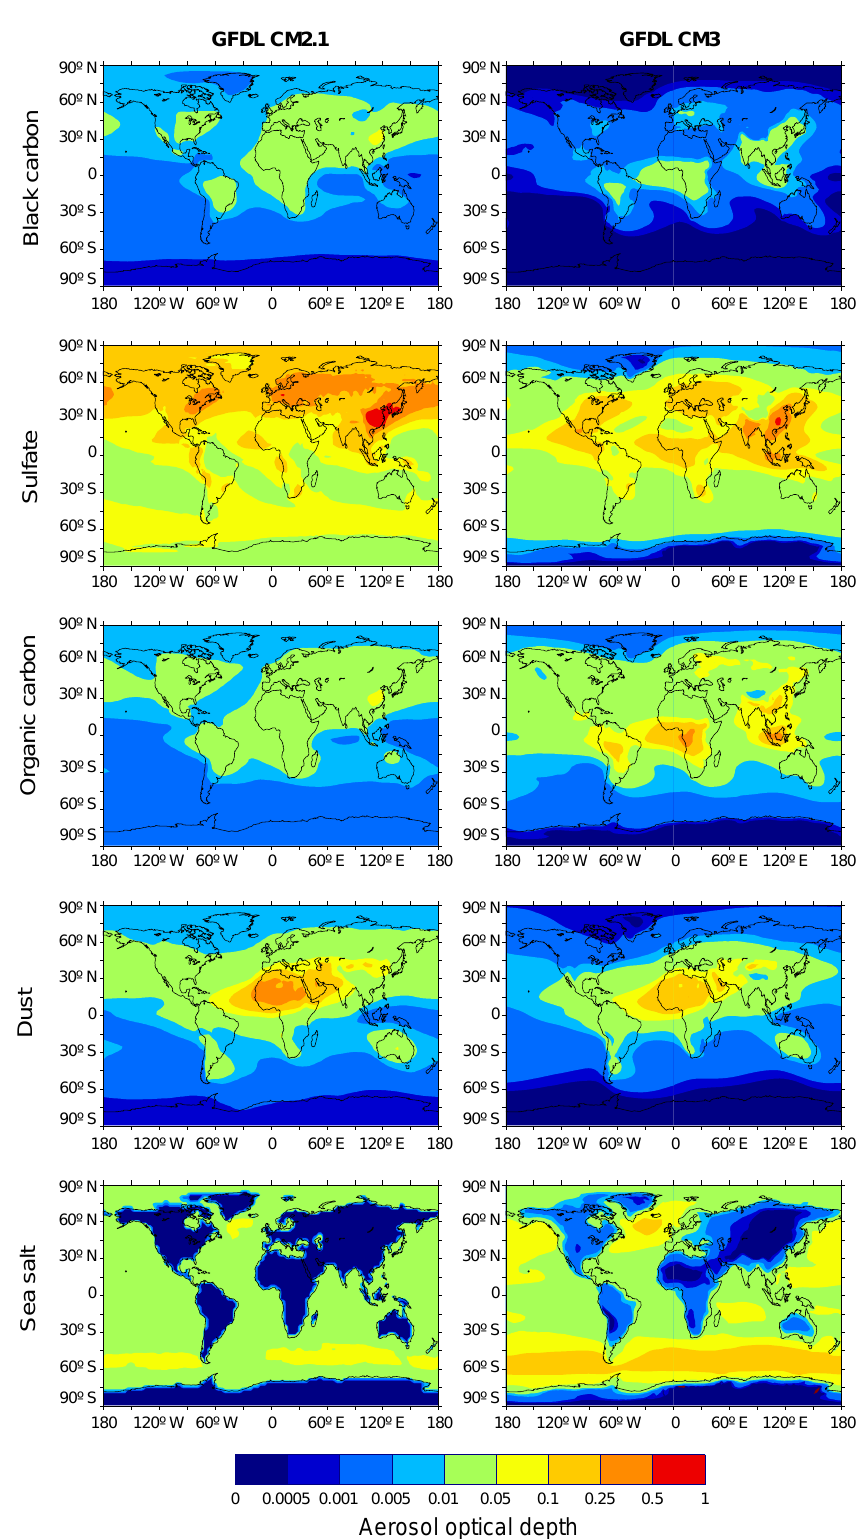
Figure 2. Model-derived aerosol optical depth by component. Five-year annual means from a five-member historical simulation ensemble: CM2.1 present-day from 1996–2000 and CM3 present-day from